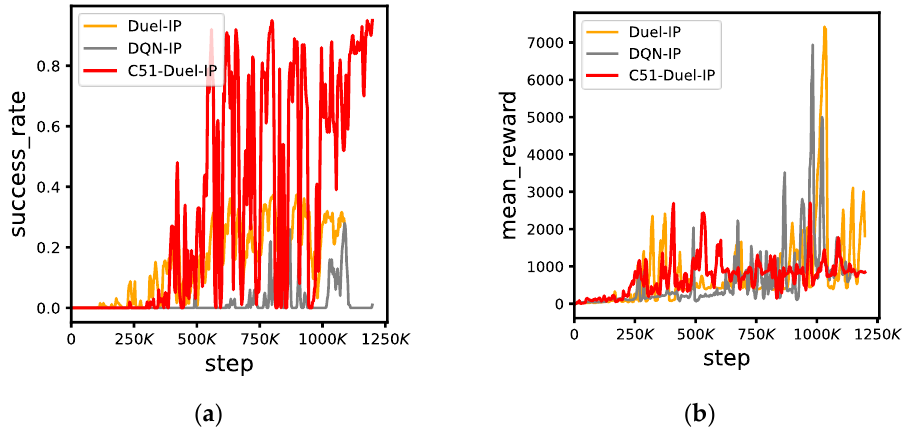
Figure 5. Scenario 1 experimental results with independent policy. The horizontal axis indicates that all the UAVs select one action. We choose the sum of episode rewards contained in 5K steps divided by the number of episodes as the average reward. The success rate takes the number of successful episodes in 5K steps divided by the total number of episodes. ( a ) Shows the success rate, ( b ) Shows the mean reward in each episode.